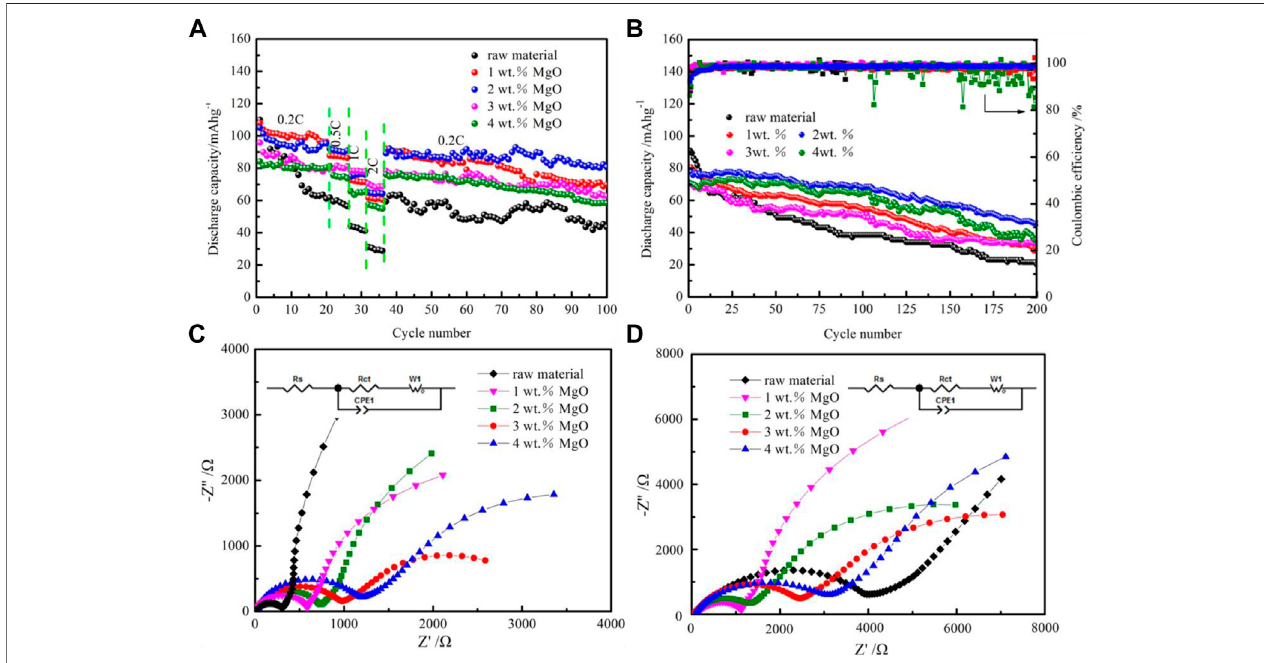
FIGURE 7 | (A) Rate and (B) long-term cycling performance and Coulombic ef fi ciencies of NM and MgO-modi fi ed materials. Nyquist plots of samples (C) before and (D) after 200 rounds of cycling.